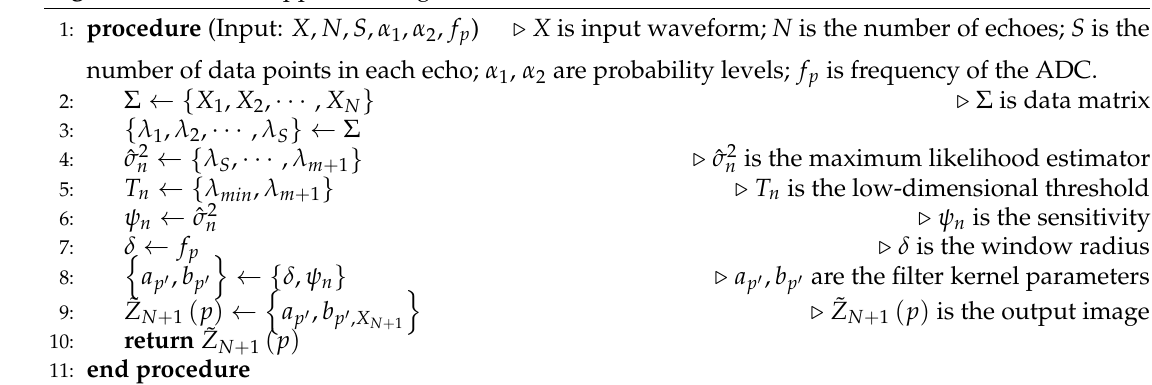
Algorithm 1 Noise suppression algorithm